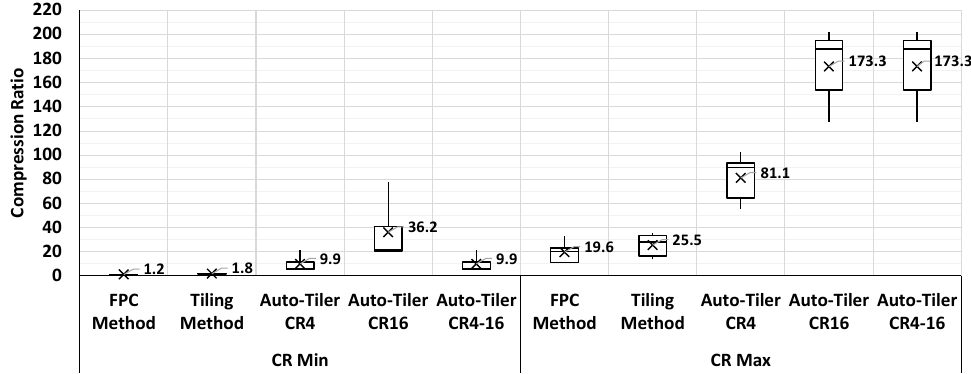
Figure 13. Effective CR comparison of an auto-tiler and existing